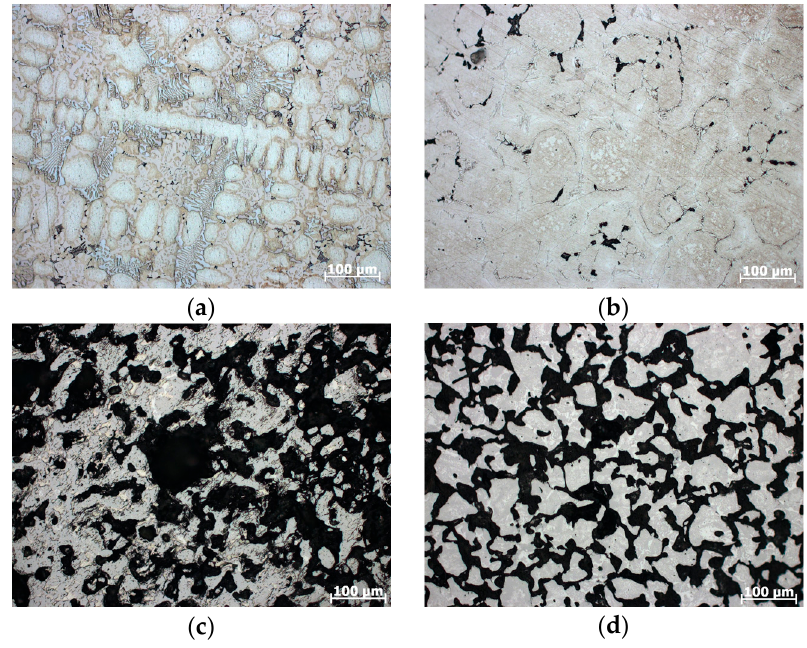
Figure 5. Sintered at 1300 °C: ( a ) microstructure of nickel-based self-fluxing alloy powder; ( b ) high-speed steel powder; ( c ) TiC-50% nickel-based self-fluxing alloy synthesized powder; and ( d ) TiC-50% high-speed steel synthesized powder.